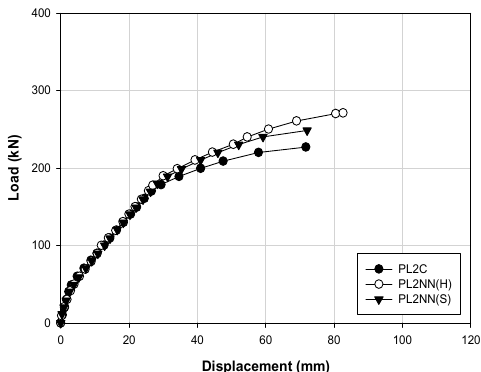
Figure 6. Load–displacement responses for different strengthening materials.